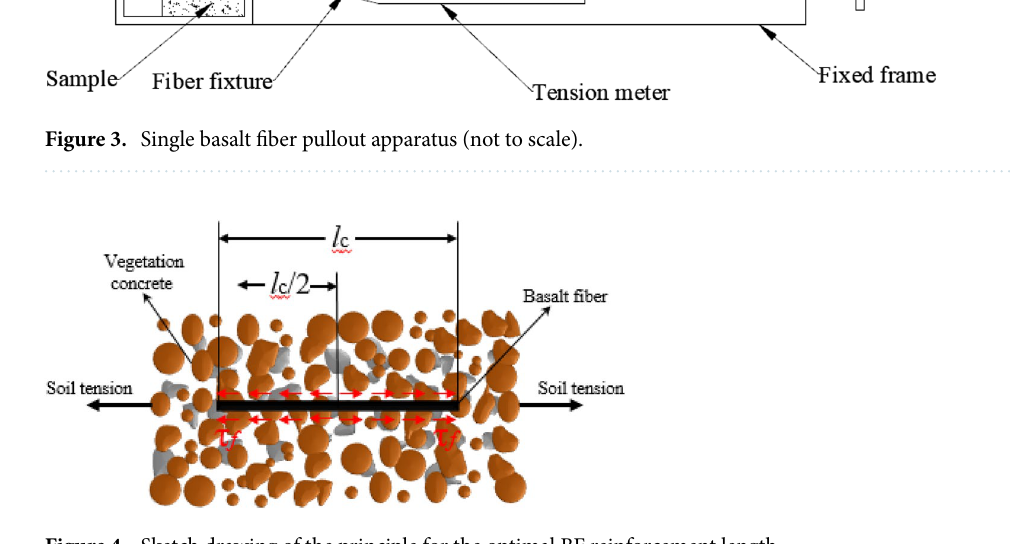
Figure 4. Sketch drawing of the principle for the optimal BF reinforcement